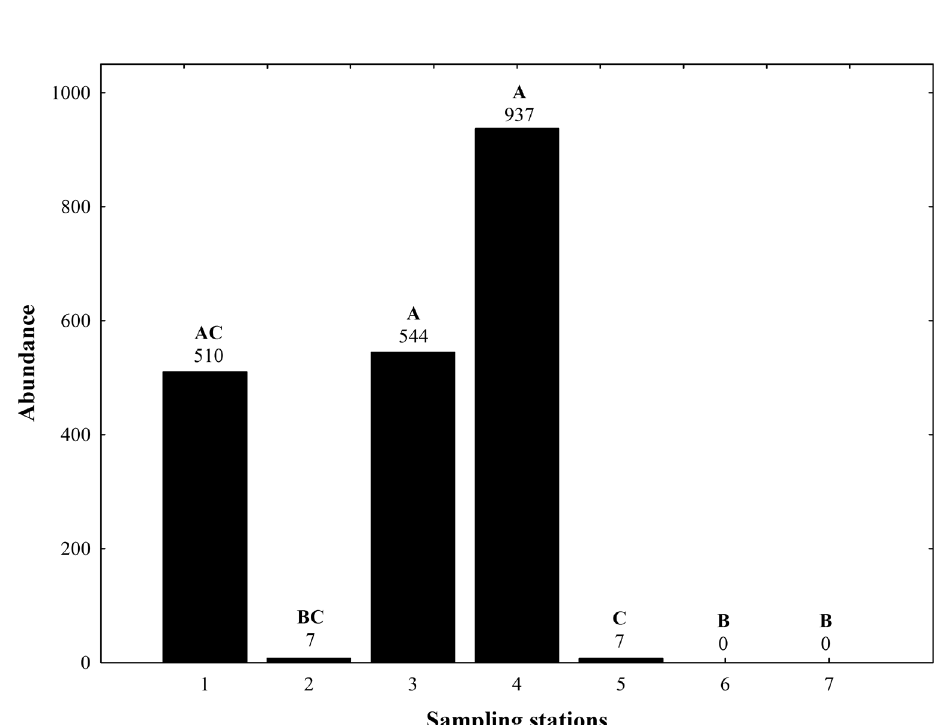
Figure 8. Spatial distribution of Exhippolysmata oplophoroides in the Cananéia region, Brazil. At least one different letter above the bars indicates significant difference between those stations (ANOVA, p <